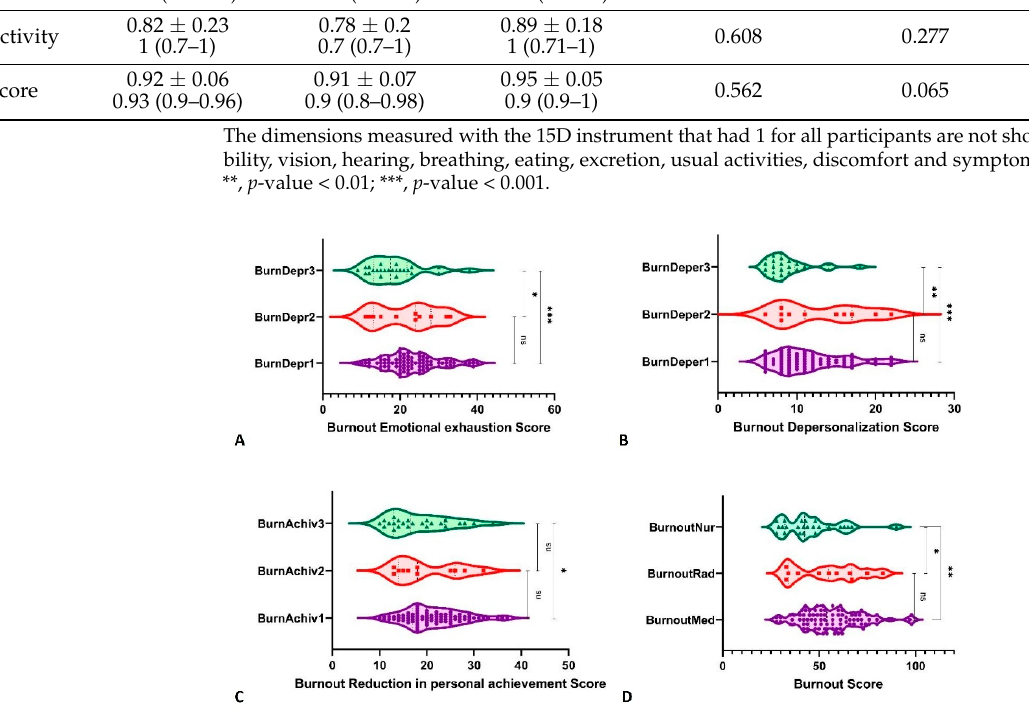
Figure 1. The same differences were maintained for the three dimensions of burnout: more EE for medical oncologists than nurses (23.28 ± 7.20 vs. 18.42 ± 6.88, p -value = 0.0012), more DP (11.59 ± 4.32 vs. 8.79 ± 2.93, p -value = 0.001), and more PA (21.44 ± 6.15 vs. 18.54 ± 6.63, p -value = 0.034).